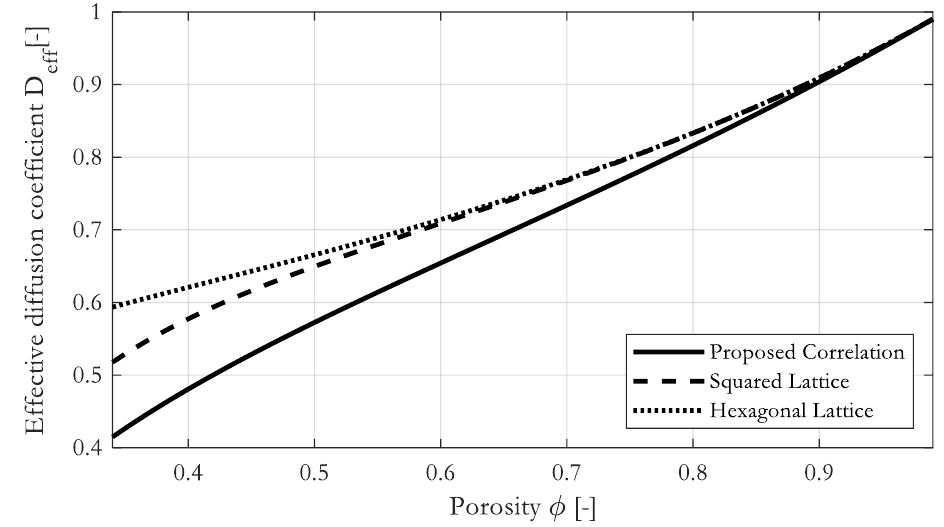
Figure 14. Comparison of the proposed correlation to correlations by Perrins et al. [28] for fibrous media to estimate the effective diffusion coefficient.